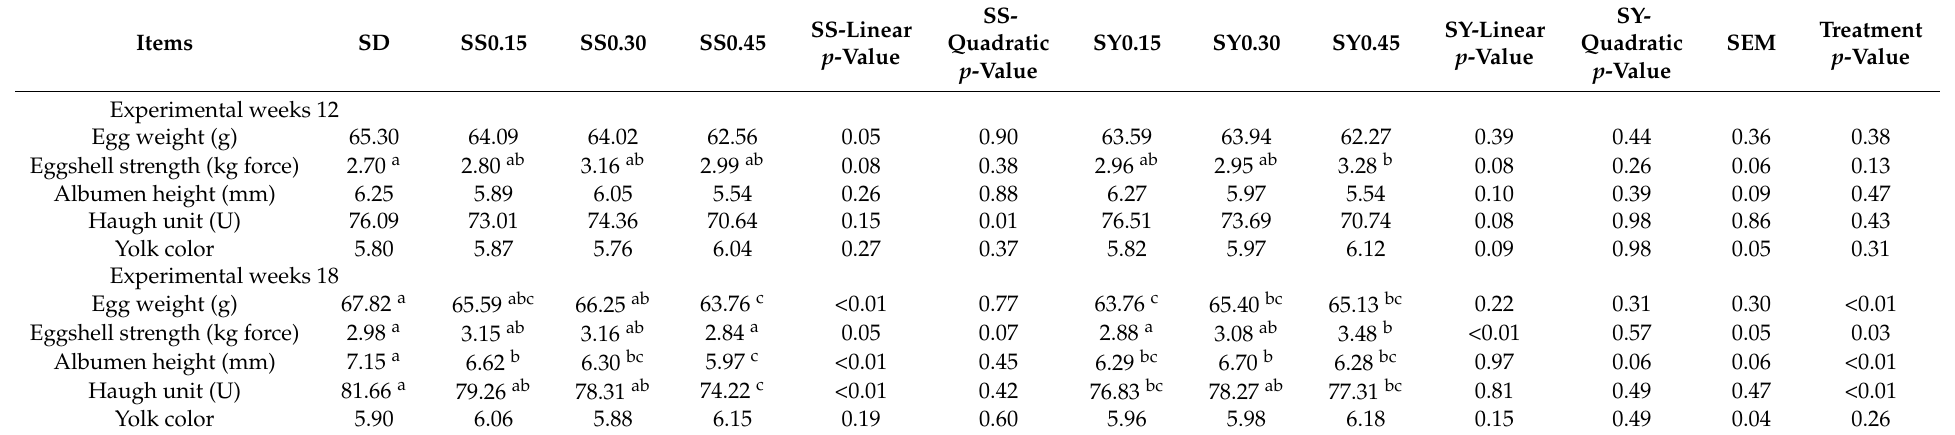
Table 6. Egg quality of aged laying hens after selenium